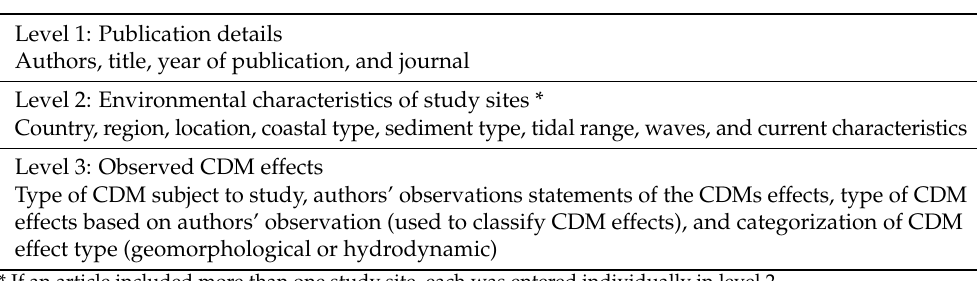
Table 2. Structure of the database which contains the information extracted from each of the se- lected publications.